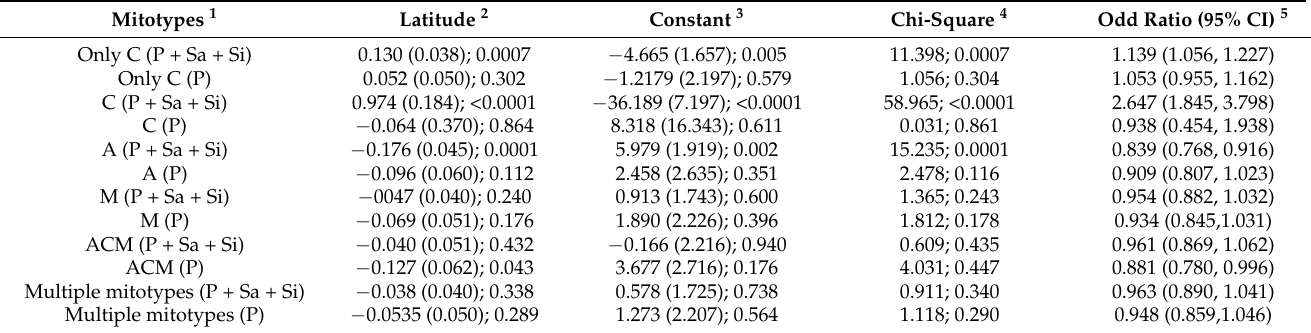
1 Dependent variables were based on honey samples with the following mitotype lineages or mitotype patterns: only C lineage in the honey, all honey samples including the C lineage, all honey samples including the A lineage, all honey samples including the M lineage, or patterns including all three main groups of mitotypes or more than one group of mitotypes, i.e., multiple mitotypes. The used mitotype information was from honey samples produced in all regions of the Italian peninsula, Sardinia and Sicily (P + Sa + Si) or only in the peninsula (P). ACM indicates honey samples that had the pattern including all three groups of mitotypes. “Multiple mitotypes” indicates honey samples that had the pattern with two or three groups of mitotypes. 2 X 1 variable: values indicate regression coefficients, their standard errors (in brackets) and the p -values. 3 Constant variable: values indicate regression coefficients, their standard errors (in brackets) and the p -values. 4 Values of the Chi-square and the probability of the test in the model. 5 Odd ratio: the predictor’s effect on the exponential function of the regression coefficient; CI: confidence